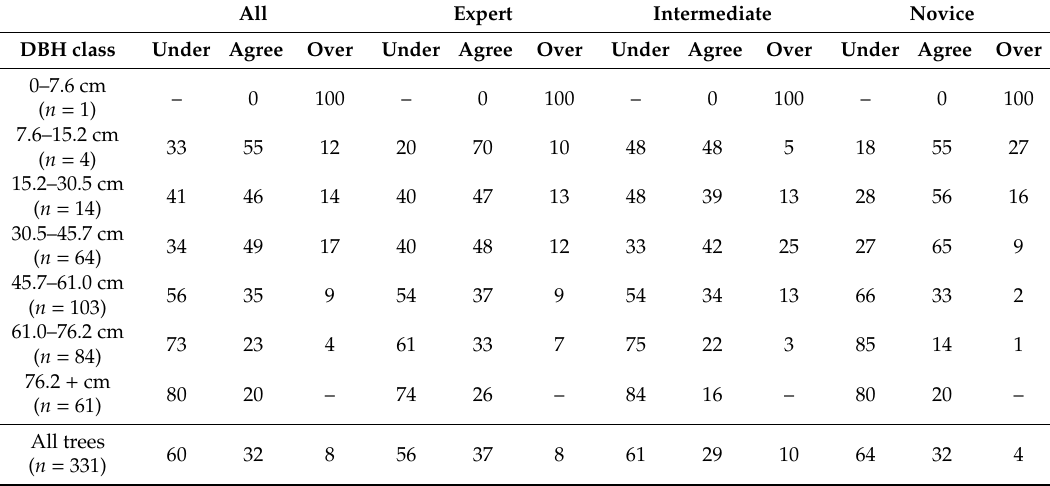
Table 3. Diameter at breast height (DBH) classification outcomes by percent, summarized by diameter class and analyst expertise. Agree indicates agreement with the field measurement, Under indicates the percent of observations for which the virtual survey analyst underestimated DBH relative to the field measurement, and Over indicates the percent of observations for which the virtual survey analyst overestimated DBH relative to the field measurement.